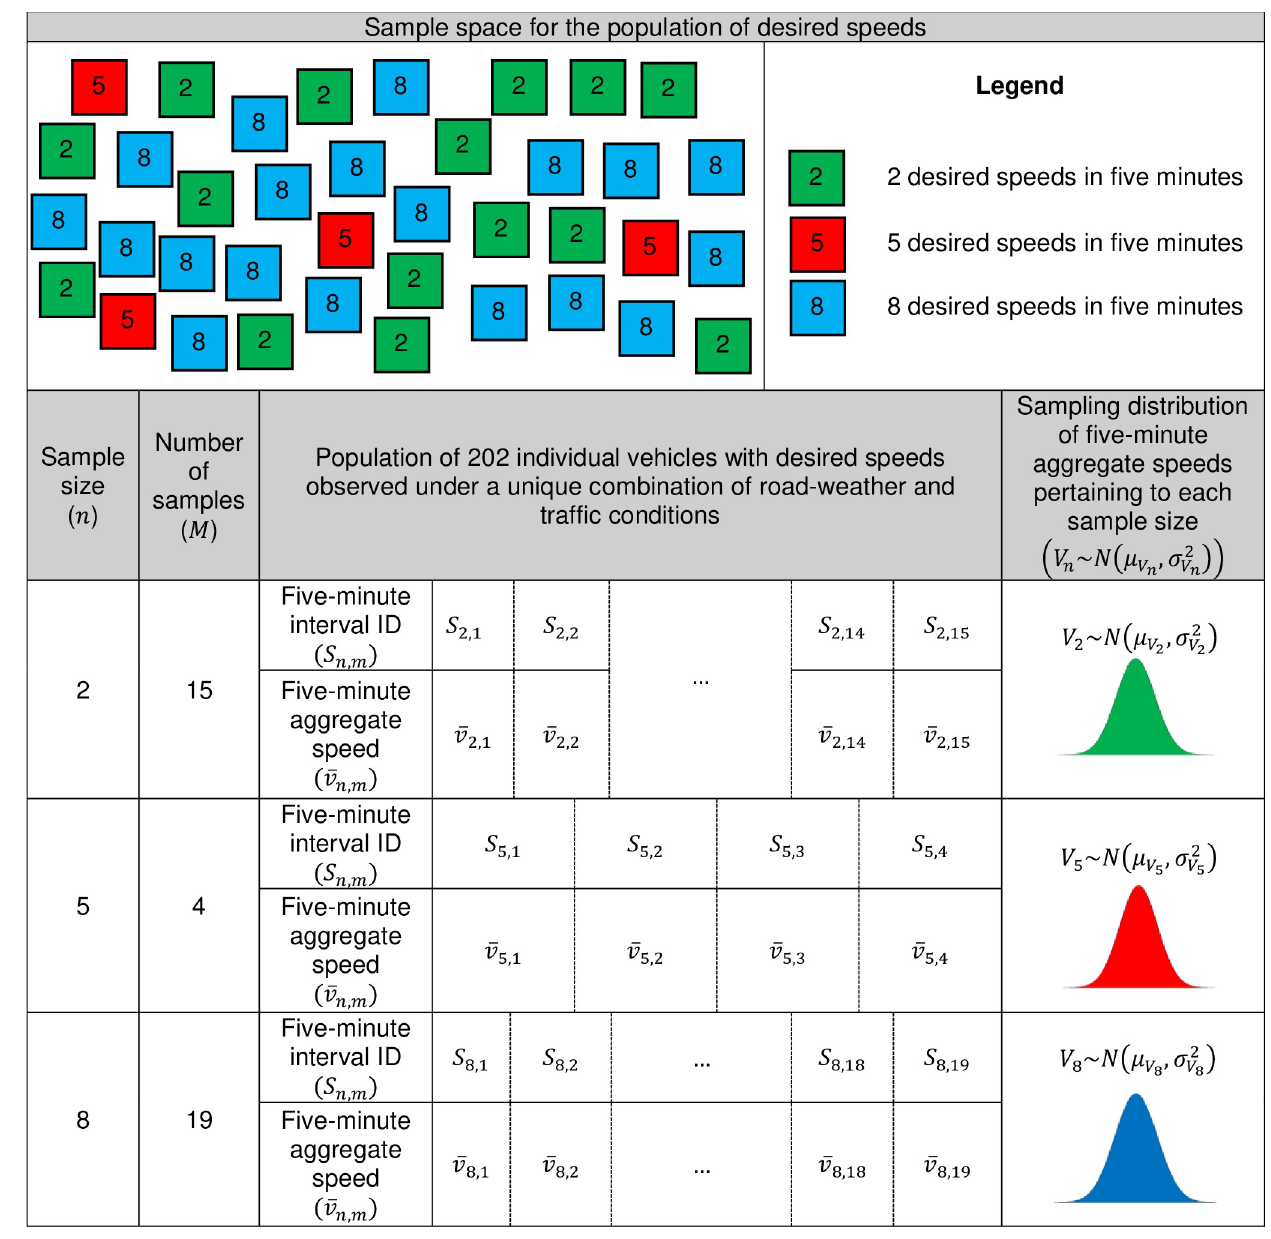
Fig 6. Illustration of a population and